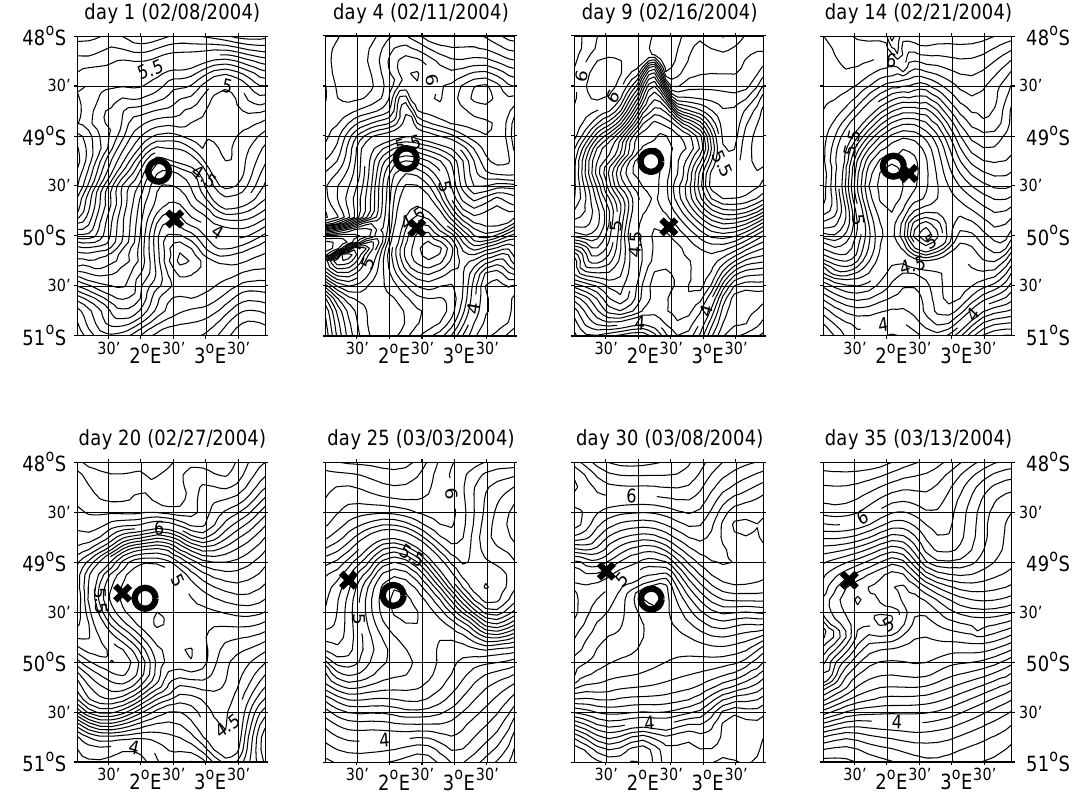
Fig. 2. Same as Figure 1, but for NLOM SST, contour interval is 0.1 ◦ C.